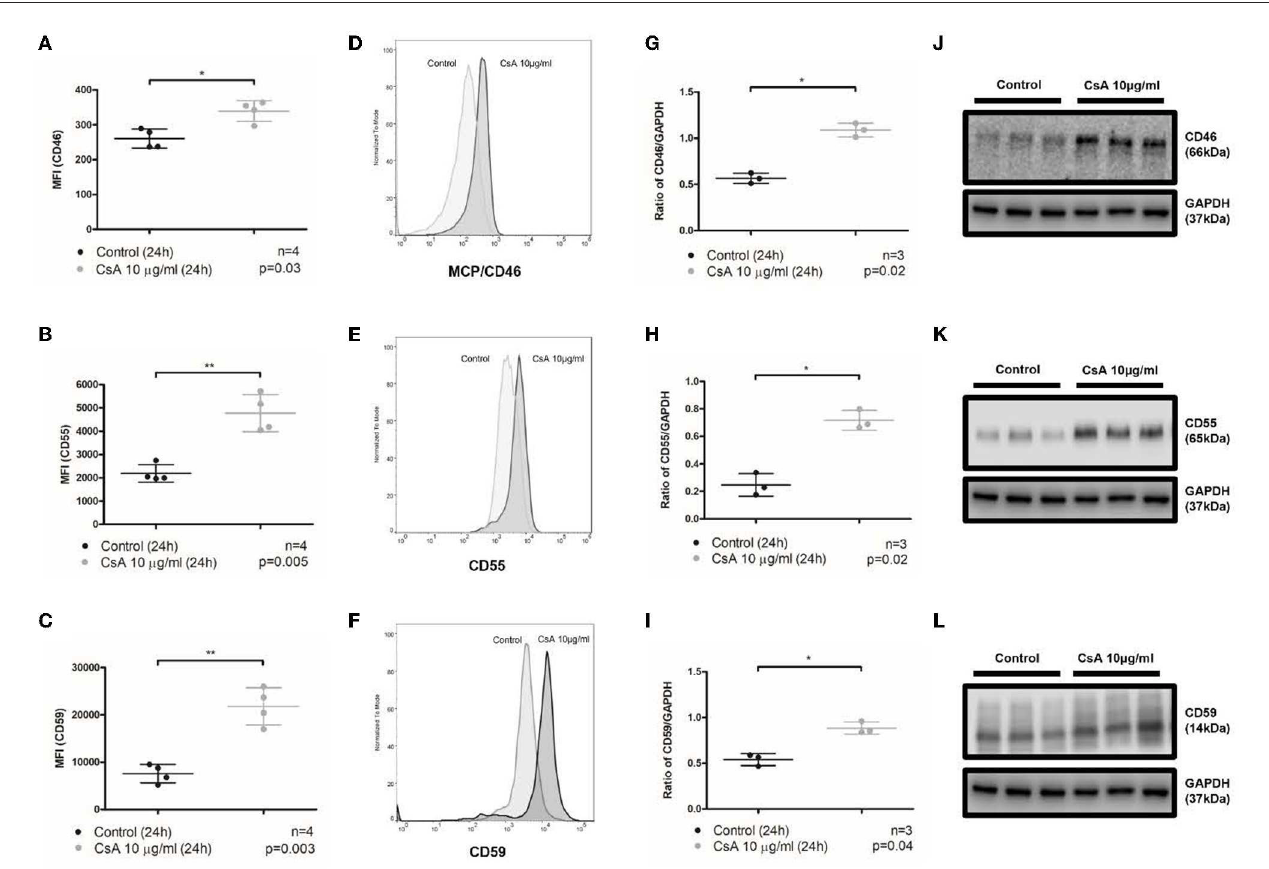
FIGURE3 Cyclosporine causes increased expression of membrane-bound complement regulators MCP/CD46, DAF/CD55, and CD59 on endothelial cell surfaces. (A–F) Blood outgrowth endothelial cell (BOEC) surface membrane-bound complement regulators detected by flow cytometry. Non-viable cells were excluded from analysis with Fixable Viability Dye eFluor 780. Graphical summary of median fluorescence intensity (MFI) from separate experiments (A–C) with representative histograms (D–F) . Compared to control, incubating BOECs in cyclosporine (CsA) 10 µ g/ml for 24h resulted in increased expression of membrane-bound complement regulators on BOEC surfaces: (A, D) MCP/CD46 ( n = 4, p = 0.03, paired, two-tailed t -test), (B, E) DAF/CD55 ( n = 4, p = 0.005, paired, two-tailed t -test), and (C, F) CD59 ( n = 4, p = 0.003, paired, two-tailed t -test). (G–L) Membrane-bound complement regulators MCP/CD46, DAF/CD55, and CD59 in cell lysates by Western blot. Graphical summary of mean gray area of specified protein band normalized to loading control from separate experiments (G–I) and Western blots (J–L). Compared to media, incubating BOECs in cyclosporine 10 µ g/ml for 24h resulted in increased BOEC protein content of membrane-bound complement regulators: (G, J) MCP/CD46 ( n = 3, p = 0.02, paired, two-tailed t -test), (H, K) DAF/CD55 ( n = 3, p = 0.02, paired, two-tailed t -test), and (I, L) CD59 ( n = 3, p = 0.04, paired, two-tailed t -test). This * and ** signifies the degree